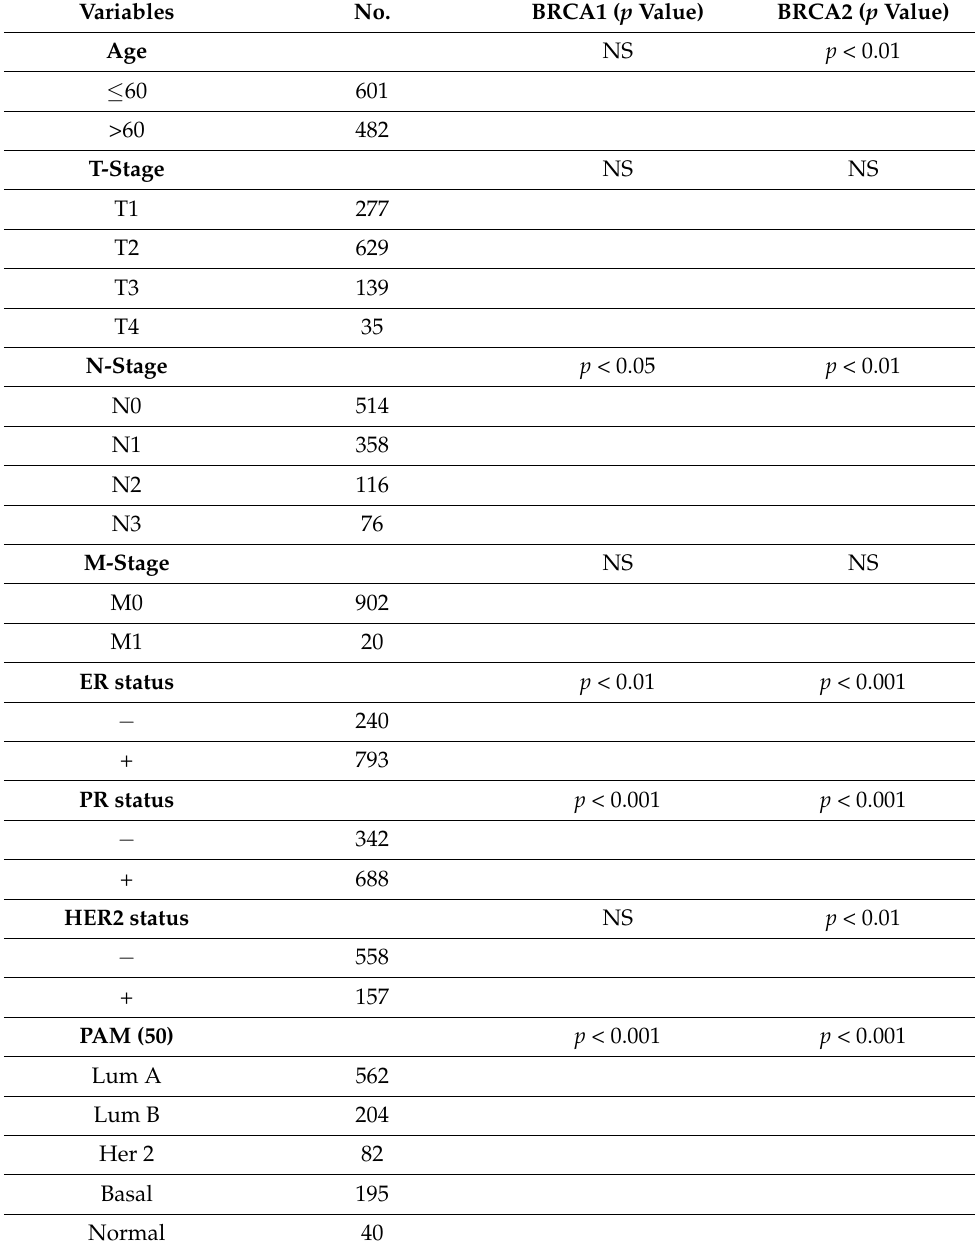
Table 2. The relationships between BRCA1/2 expression and clinicopathological features in Breast Cancer. Variables No. BRCA1 ( p